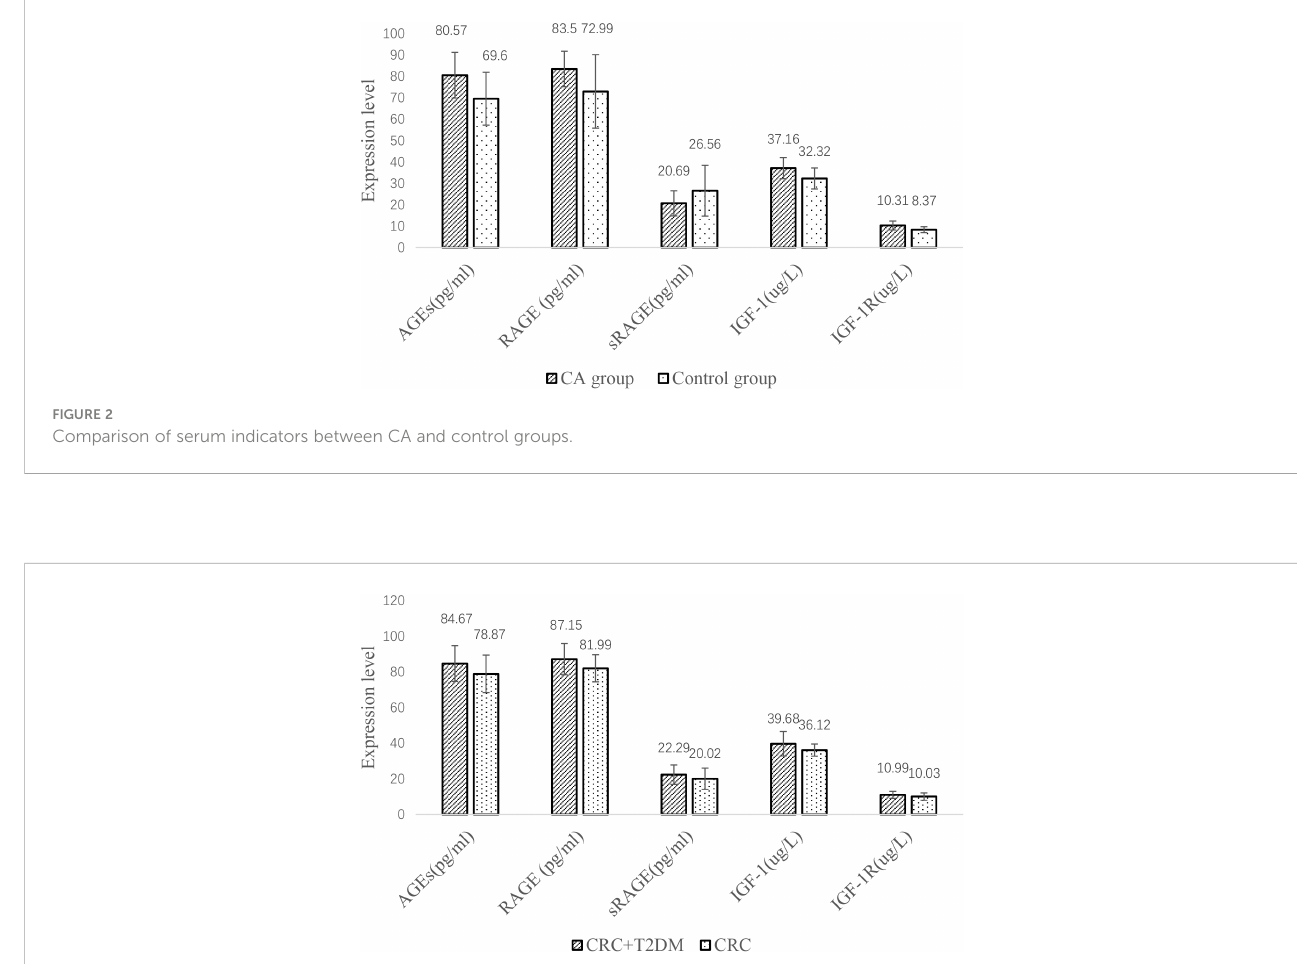
FIGURE 3 Comparison of the CRC group and CRC+T2DM group.